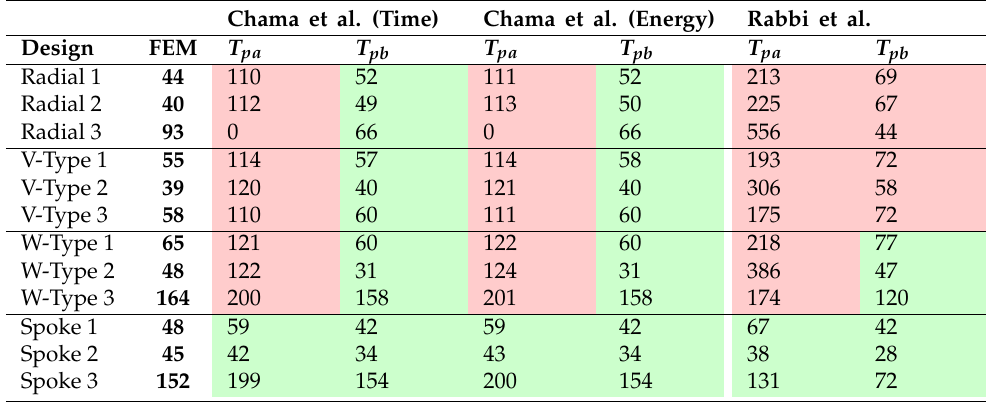
Table 1. x cr determined by various analytical methods for the machine